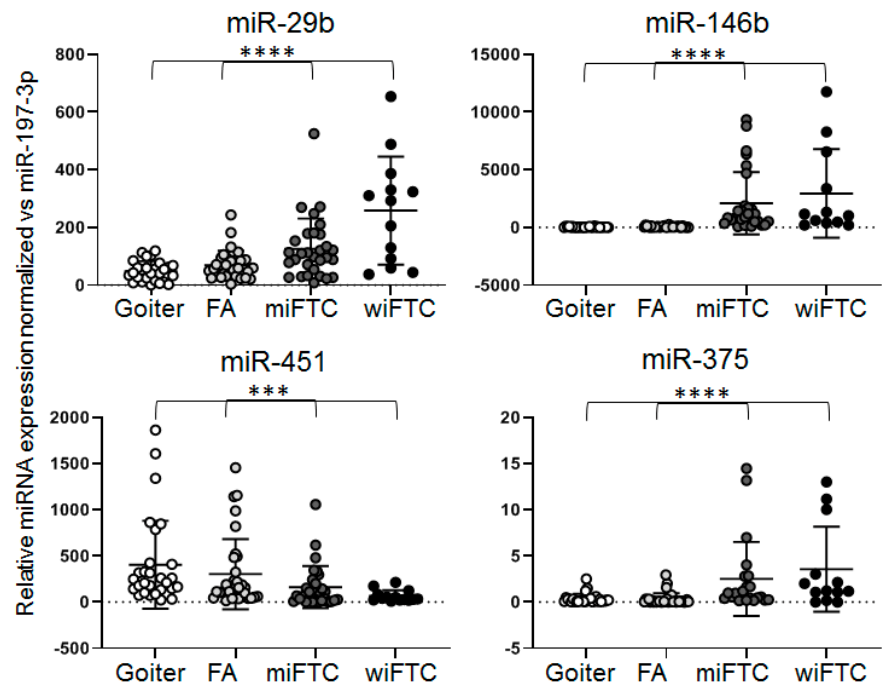
Figure 3. RT-qPCR analysis of selected miRNAs in individual RNA samples by Spec-TT systems.Results RT-qPCR were normalized to global mean Ct value. Statistical significance of the difference between four groups was evaluated by Kruskal–Wallis test is indicated by *** ( p < 0.0005) and **** ( p < 0.00005).